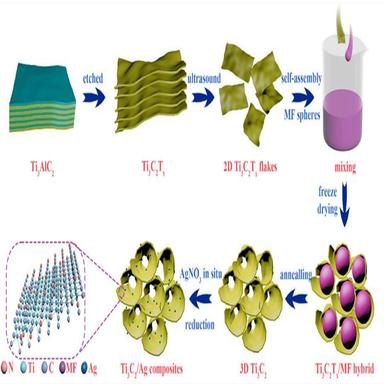
Schematic illustration of the preparation process used to manufacture 3D honeycomb-like MXene/Ag composites.